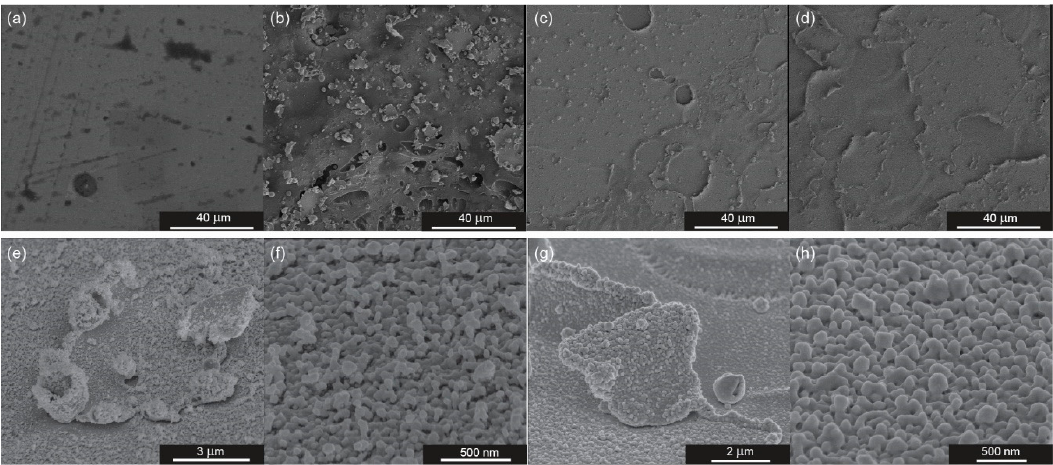
Figure 4. Scanning electron microscopy (SEM) images of PET/ITO foil in few different states of SERS platform preparation: ( a ) raw PET/ITO foil without any modifications, ( b ) foil after 90 s of the DBD, ( c ) foil modified with DBD and with 30 nm layer of silver, ( d ) foil modified with DBD and with 70 nm layer of silver, ( e , f ) images of foil modified with DBD and with 30 nm layer of silver at high magnifications, and ( g , h ) images of foil modified with DBD and with 70 nm layer of silver at high magnifications.